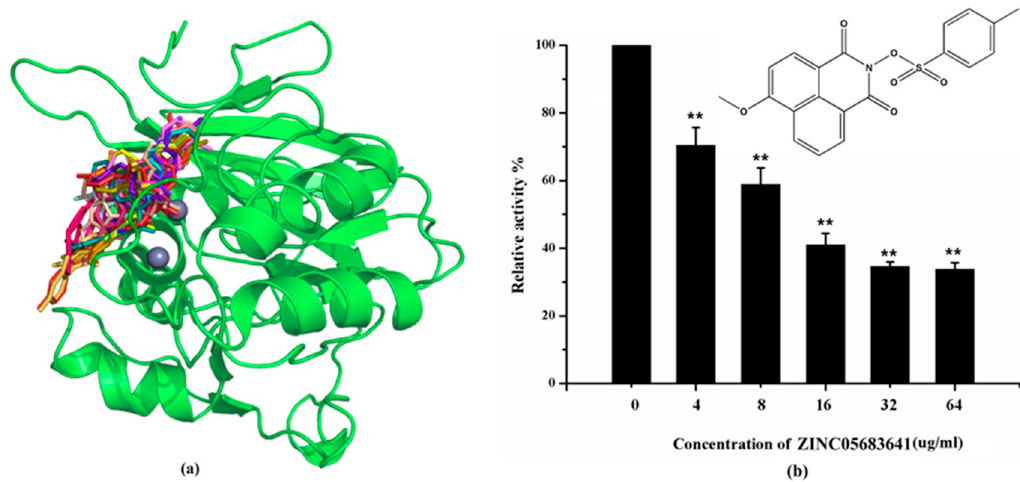
Figure 1. Virtual screening and Enzyme inhibition assay. ( a ) The potential bind mode of 18 compounds to NDM-1 (the Zn ions in active site are shown as spheres); ( b ) The inhibitory effect of ZINC05683641 on NDM-1 and the chemical structure of ZINC05683641. The hydrolysis of nitrocefin in NDM-1 was reduced by the addition of various concentrations on ZINC05683641 after measured at OD492nm. The column diagrams showed the average values for the assays in triplicate, and bars represent the standard deviation. ** indicates p < 0.01 compared with the drug-free group; two-tailed Student’s test.